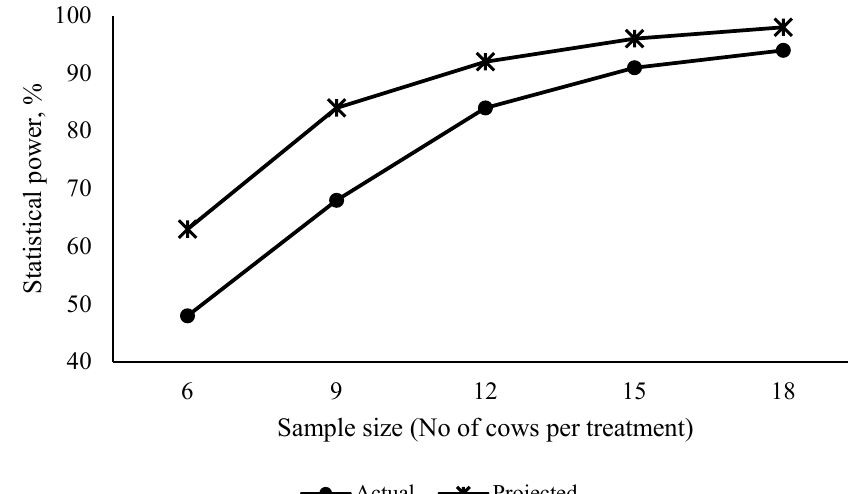
Figure 1. Plot of statistical power vs sample size. Projected and actual statistical power for different samples sizes that calculated at an alpha level 0.05. Anticipated treatment variability from the literature data were used in projecting statistical power at the research planning stage while actual treatment variability in nutrient digestion were used to determine actual statistical power at each sample size.